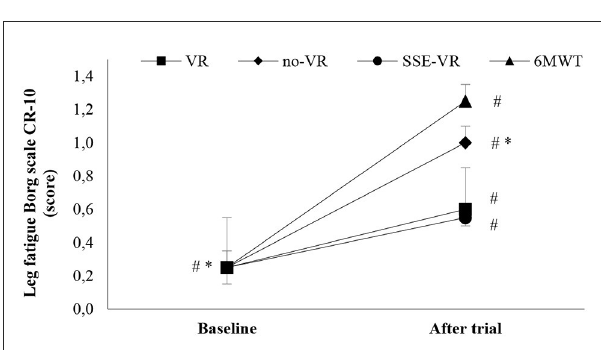
statistically significant correlation was detected between handgrip strength and leg fatigue at the end of the VR ( r = − 0.621, p